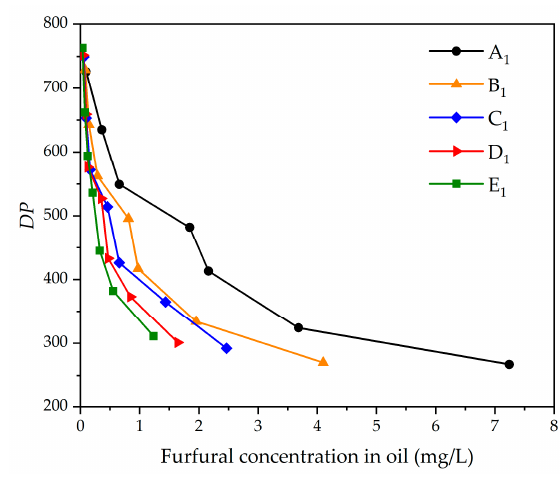
Figure 7. The relationship between furfural concentration oil and degree of polymerization ( DP ).